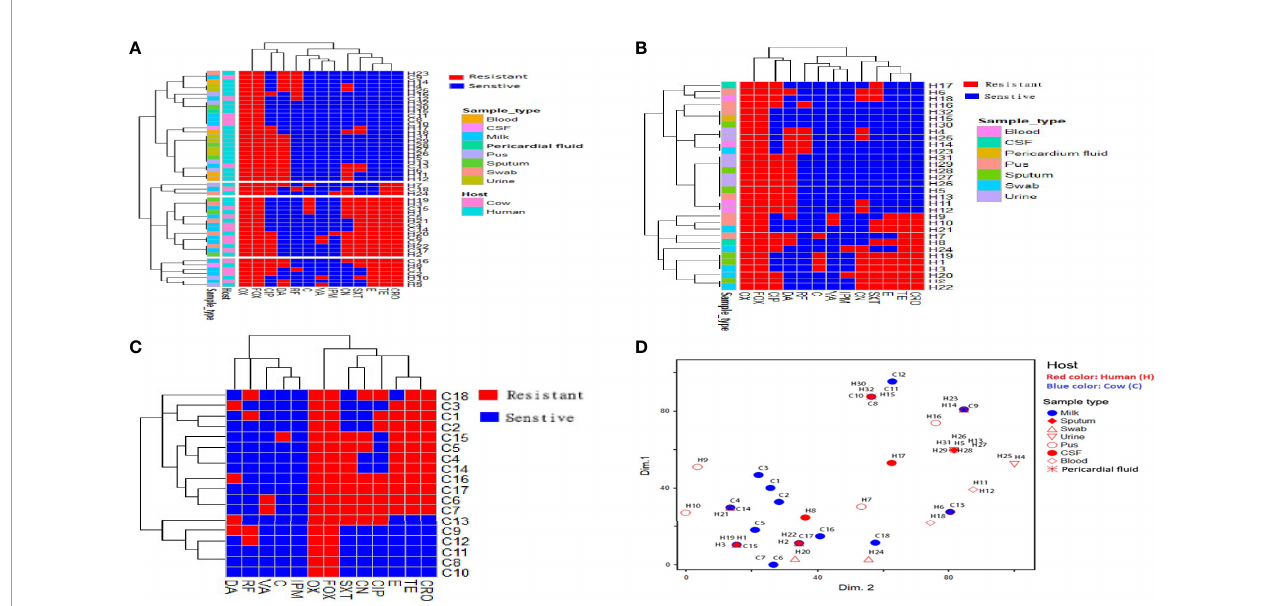
FIGURE 1 | Distribution and hierarchical clustering of ST239 methicillin-resistant Staphylococcus aureus (MRSA) strains and the antimicrobial resistance variables based on the antimicrobial resistance pro fi les. (A – C) Heatmap showing the occurrence of antimicrobial resistance in the studied strains; all, human, and animal ST239 MRSA, respectively. Red and blue colors refer to resistance and sensitivity to a particular antimicrobial, respectively. The dendrogram represents the hierarchical clustering of the strains and antimicrobial resistance variables. The vertical lines dropped from the dendrogram branches show the 10 clusters that contained identical isolates. Different categories of hosts and sample types are color-coded on the right of the heatmap. (D) Non-metric multidimensional scaling analysis showing the overlap of ST239-MRSA strains belonging to different hosts and sample types based on antimicrobial resistance pro fi le. CIP, cipro fl oxacin; RF, rifamycin SV; TE, tetracycline; CRO, ceftriaxone; E, erythromycin; C, chloramphenicol; VA, vancomycin; DA, clindamycin; SXT, trimethoprim ‐ sulfamethoxazole; CN, gentamicin; IPM, imipenem; OX, oxacillin; FOX,